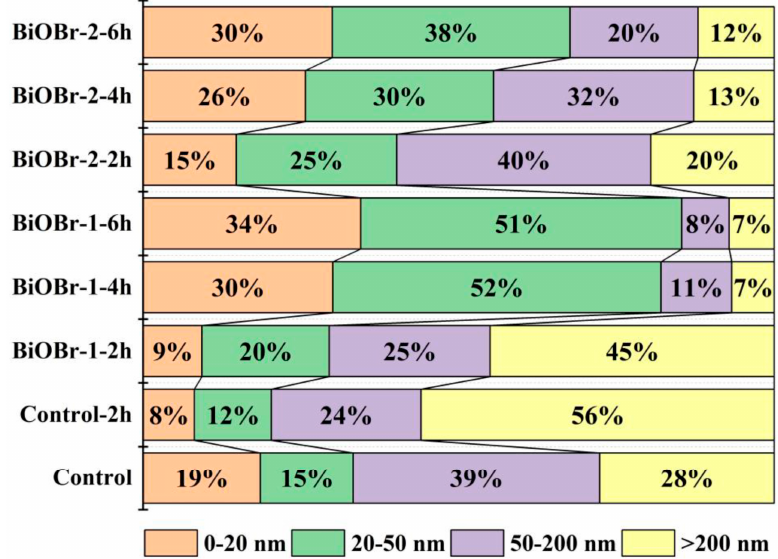
Figure 10. The proportion of different types of pores in samples.